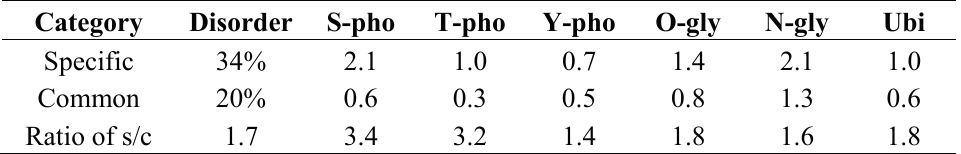
Table 3. Preference of protein disorder and PTM in species-specific protein clusters and common protein clusters of algae